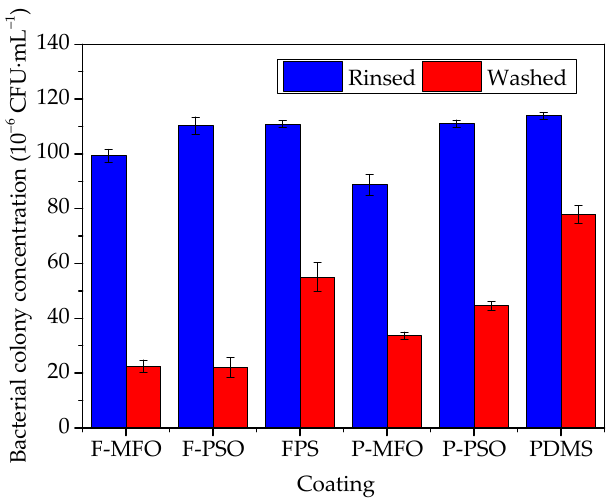
Figure 10. Colony concentration of bacteria attached on studied coatings.